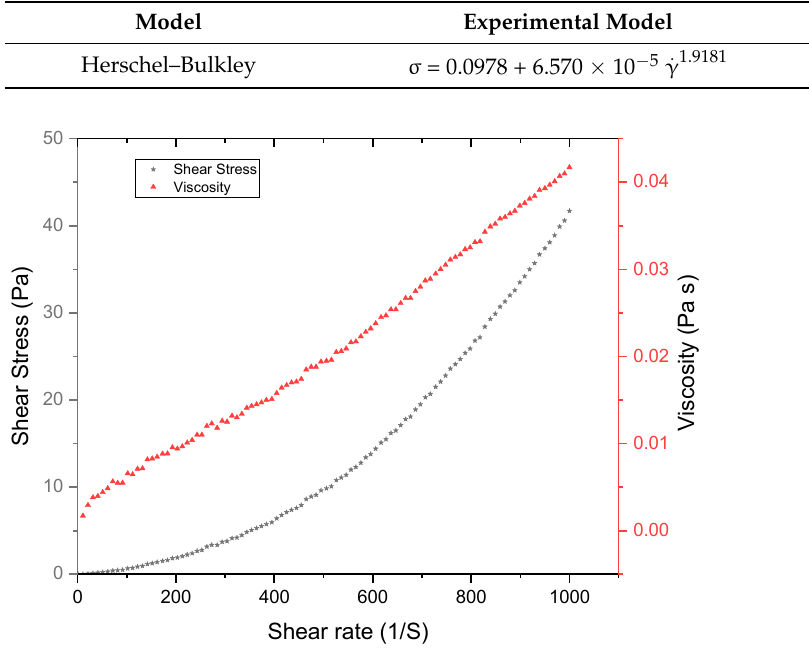
Table 3. Herschel–Bulkley experimental model parameters for the enzyme at 25 °C.